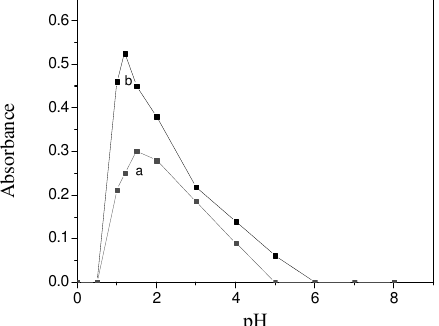
Figure 3 . Influence of pH on the extraction of the complex ion associates [Tz] + . [BiI acetone-chloroform (1:1v/v) (a) and [Phen] + .[BiI